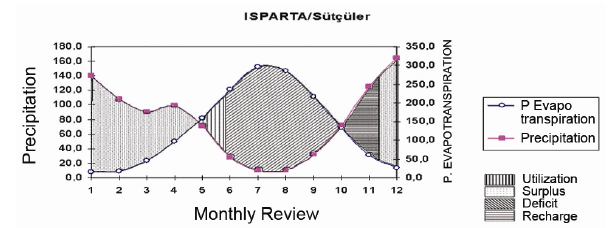
Fig. 2. Water balance diagram of Sutculer District The Yazili Canyon, a deeply cut valley, consists of coarse limestone from the Cretaceous period (JEO-TEK and UTTA 2006). Altitudinal difference of the Canyon between the base and the ceiling ranges from 100 m to 400 m.